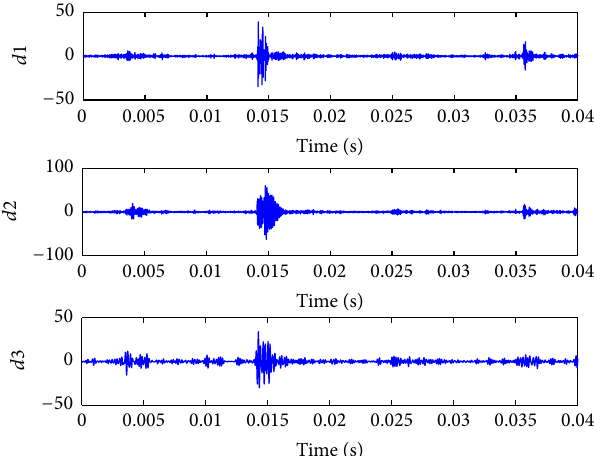
Figure 15: The DWT result of cylinder block vibration signal measured at 2800 rpm